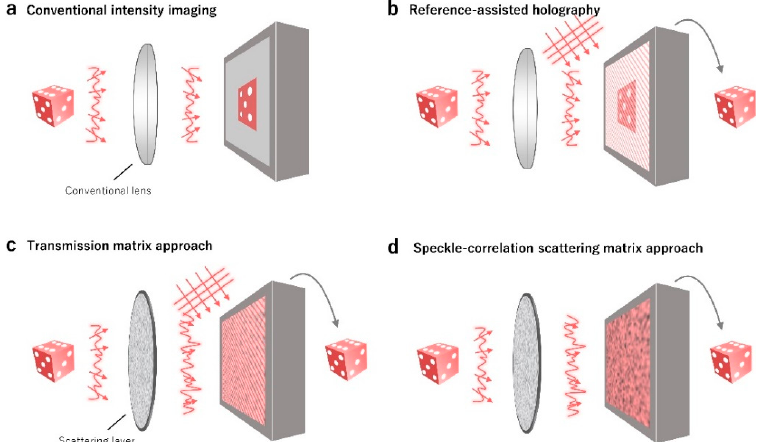
Figure 1. The comparison between the speckle correlation scattering matrix (SSM) method and conventional imaging methods. ( a ) Intensity imaging does not access the phase information of light. ( b ) Off-axis holography or reference-assisted holography technique can retrieve phase information from an interference pattern. However, it requires the use of a well-defined known reference beam. ( c ) Transmission matrix (TM)-based approach exploits the deterministic natures of light propagation through complex media, and enables the retrieval of phase information. However, it is generally based on off-axis holography and requires the use of a reference beam. ( d ) The SSM also exploits the deterministic nature of multiple light scattering. However, the phase information is exploited in terms of speckle-correlation, and removes the needs for a reference beam. Modified with permission from [36], NPG.